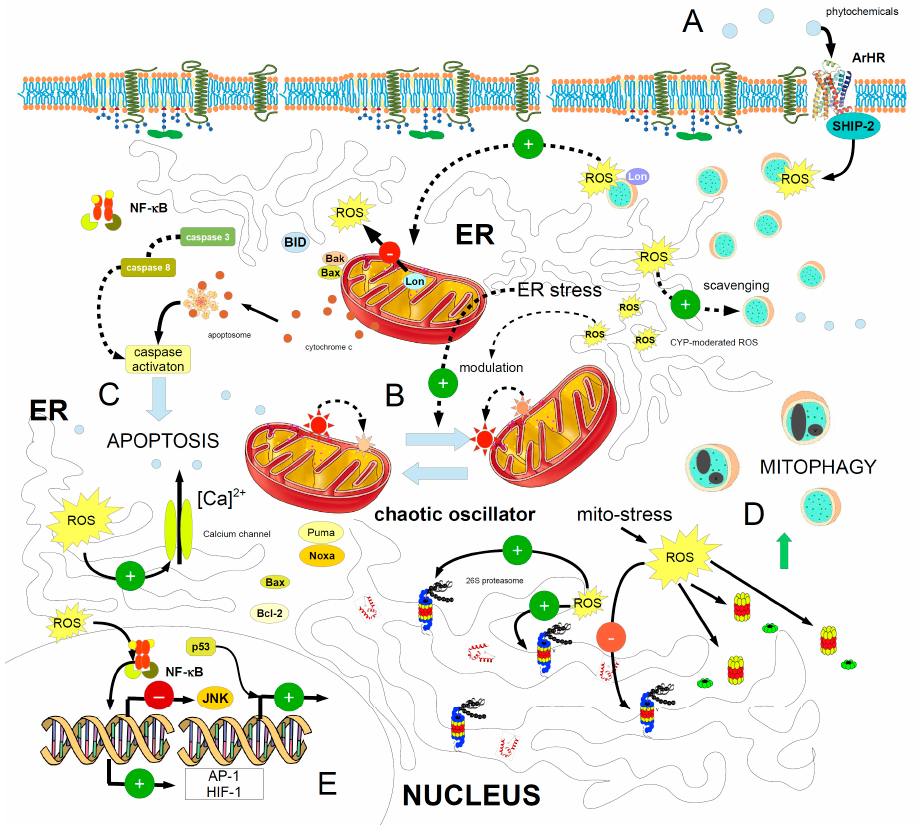
Figure 2. The major pathways and mechanisms of the cell stress response to phytochemicals and existence of the proterome. ( A ) The phytochemical targets an aryl hydrocarbon receptor (ArHR) and generates ROS through a signalling involving membrane, SHIP-2; lysosomes are the source of ROS, as signal molecules. Lysosome Lon proteases activate mitochondrial Lon homologues, which dampen ROS production from the mitochondria; ( B ) Mitochondria form a chaotic oscillator through their inner membrane potential, which is initially modulated and maintained (through a synchronization) by ROS of ER stress, which also activates the scavenging of stressors by lysosomes. This is a major hub in the cell homeodynamics, because the choice between mitophagy and apoptosis depends on the many factors (discussed in the text) unbalancing this ER stress/mitochondria relationship; ( C ) Shifts in the oscillatory mechanism of the intracellular calcium, in a persistent high presence of ROS, may lead to apoptosis; ( D ) Stress accretion and a high amount of ROS leads to the proteasome breaking down, with release of the 20S and the regulatory units and activation of the autophagy; ( E ) Genetic control of ROS. Green positive symbols mean activation or induction; red negative ones mean inhibition. The greater the ROS yellow flash, the higher the ROS concentration or persistence. Dashed arrows: activity to be assessed (hypothetical or not yet fully elucidated). Sign plus = activation; sign minus = inhibition. See text for details.